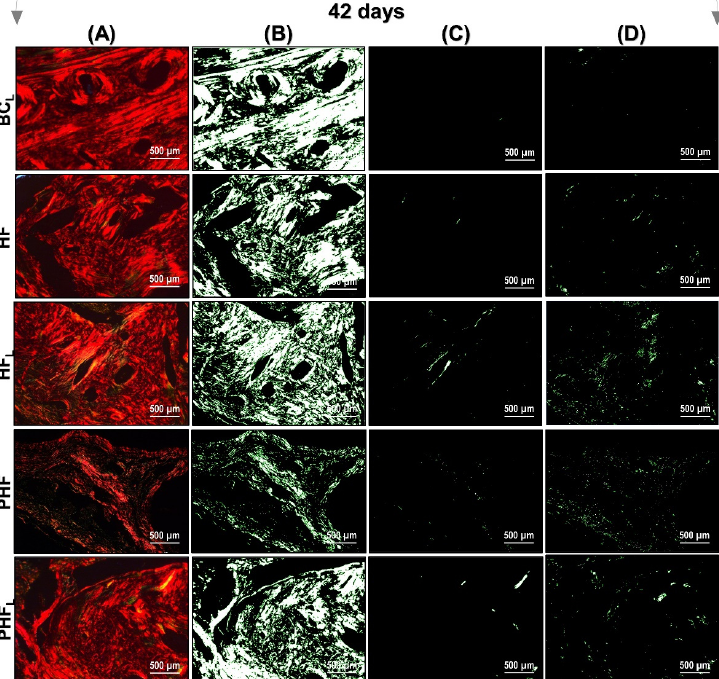
Figure 7. Images of Picrosirius-red stained sections observed by polarized light microscopy after 42 days. n = 12/group): BCL, HF, HFL, PHF and PHFL groups. ( A ) Polarized image showing the deposition of birefringent collagen (arrows); ( B ) Regions marked in red; ( C ) Regions marked in yellow corresponding to polarizing collagen deposition; ( D ) Regions marked in green. The yellowish–green birefringence of collagen fibers corresponds to thin bundles with diverse and disorganized arrangements, and reddish corresponds to dense and organized bundles, Picrosirius-red under polarization, 40× objective. Bars = 500 µm.